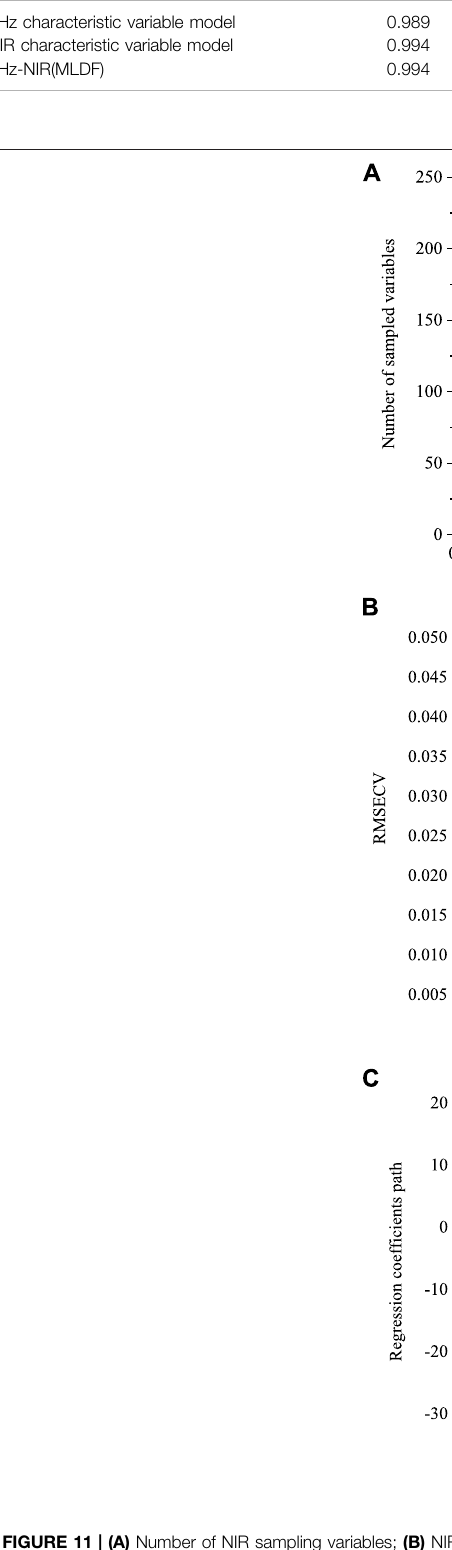
FIGURE 11 | (A) Number of NIR sampling variables; (B) NIR RMSECV; (C) NIR regression coef fi cient.